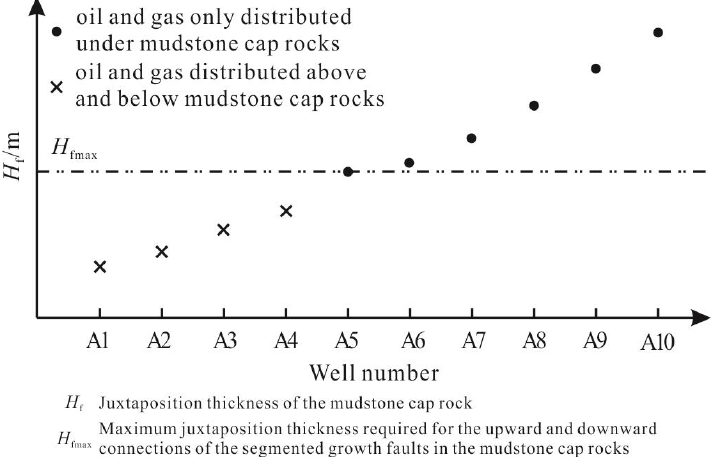
Figure 3. Determination of the maximum juxtaposition thickness required for the upward and downward connections of the segmented growth faults in the mudstone cap rocks.